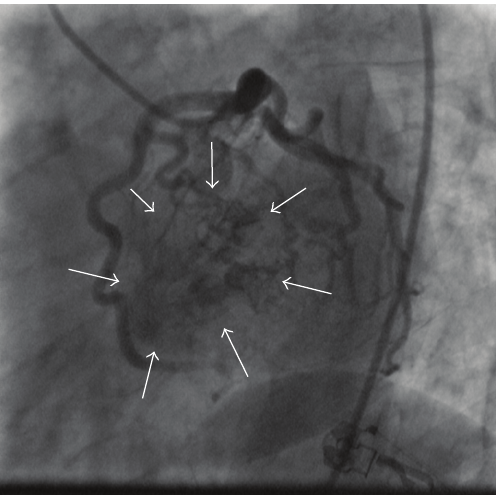
Figure4:Selectivecoronaryangiography( spiderview )showsalarge mass of contrast in the left ventricle